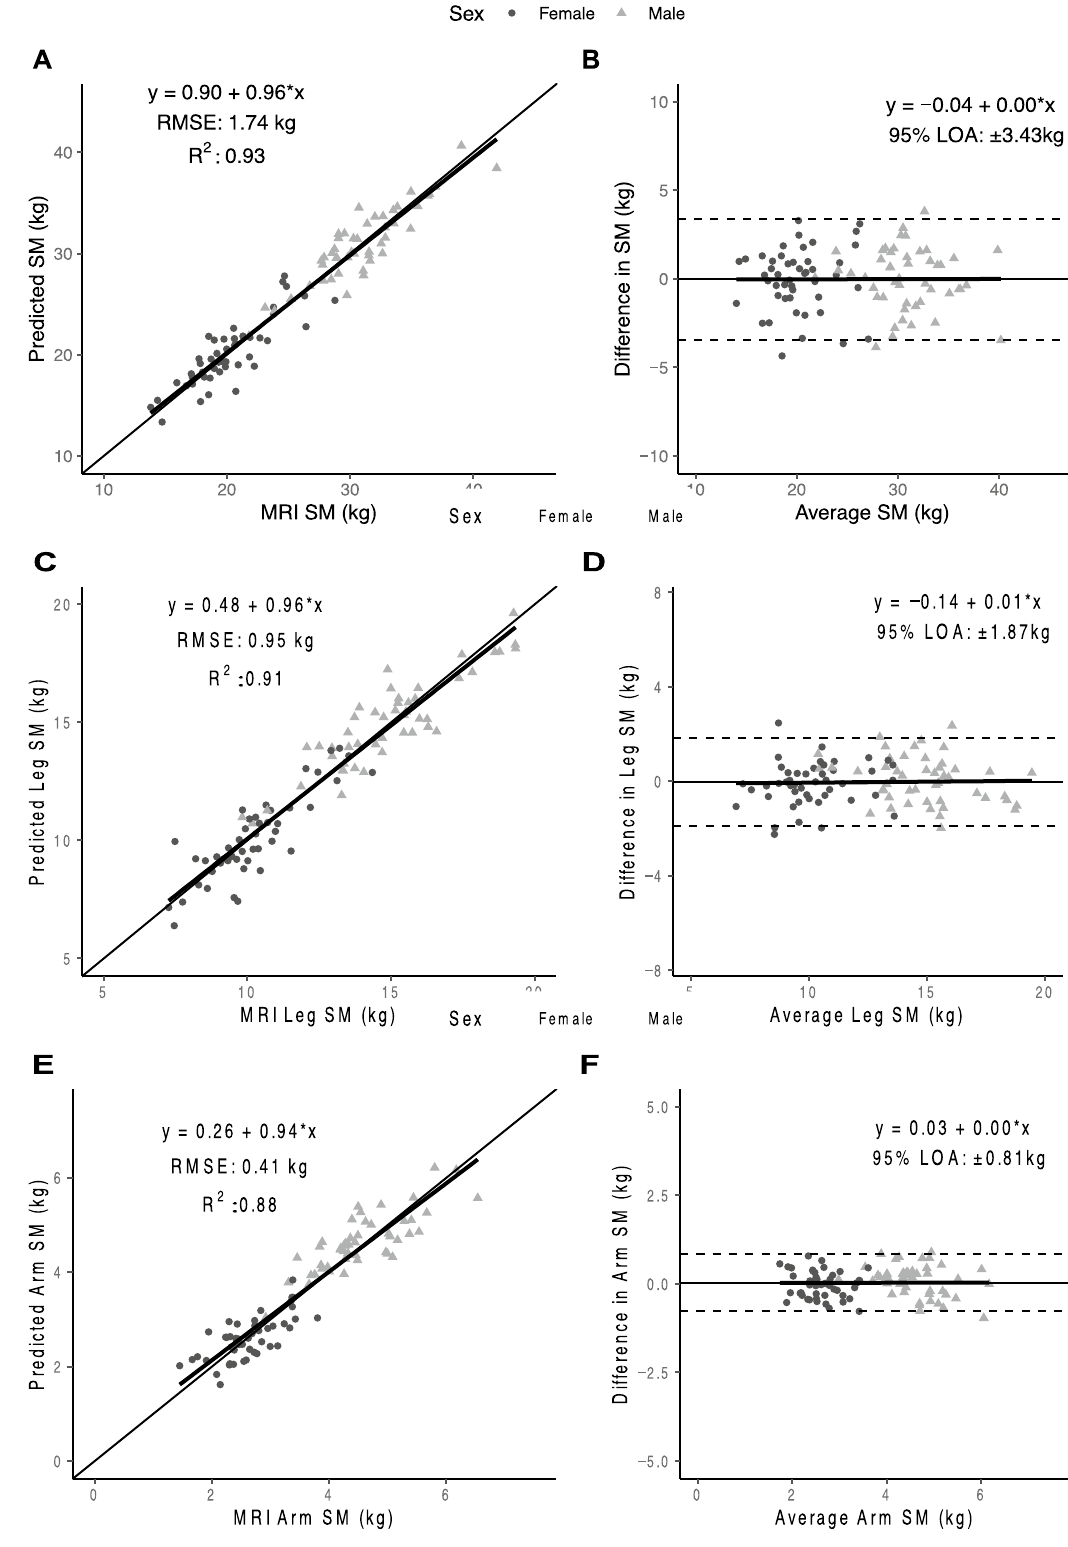
Figure 2. Predicted total, arm, and leg skeletal muscle (SM) mass versus corresponding value measured with MRI in the validation sample (n = 47 women; 48 men) on the left ( A,C,E ) and associated Bland–Altman plots on the right ( B,D,F ). The regression equations, lines, R 2 s, and 95% limits of agreement (LOA) are shown in the figures. The statistical significance of each panel is summarized in the